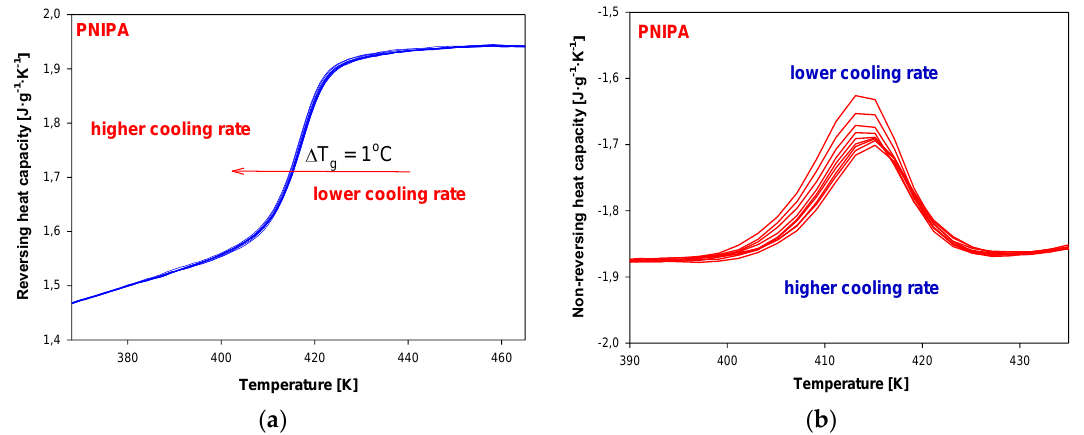
Figure 17. ( a ) Reversing heat capacity of amorphous PNIPA versus temperature obtained based on the non-isothermal aging. ( b ) Non-reversing heat capacity of amorphous PNIPA versus temperature obtained based on the non-isothermal aging.